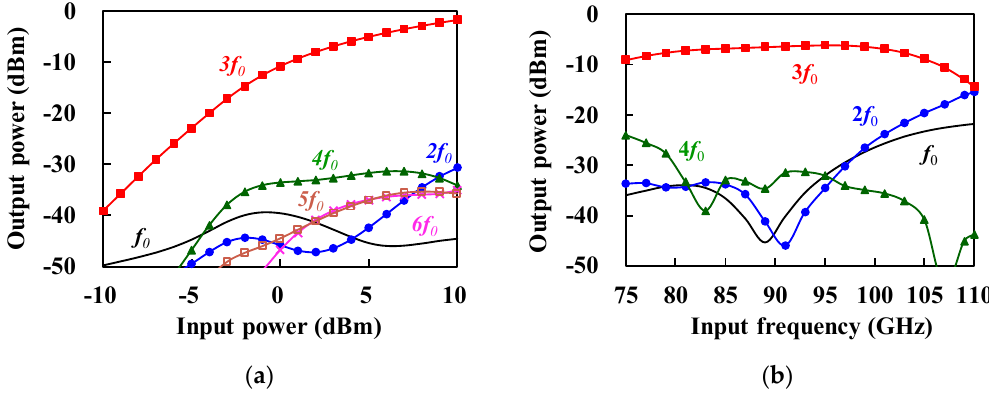
Figure 3. Simulated performance of the designed frequency tripler. ( a ) Output power as a function of input power at f 0 = 90 GHz; ( b ) output power as a function of frequency at an input power of 3.5 dBm.